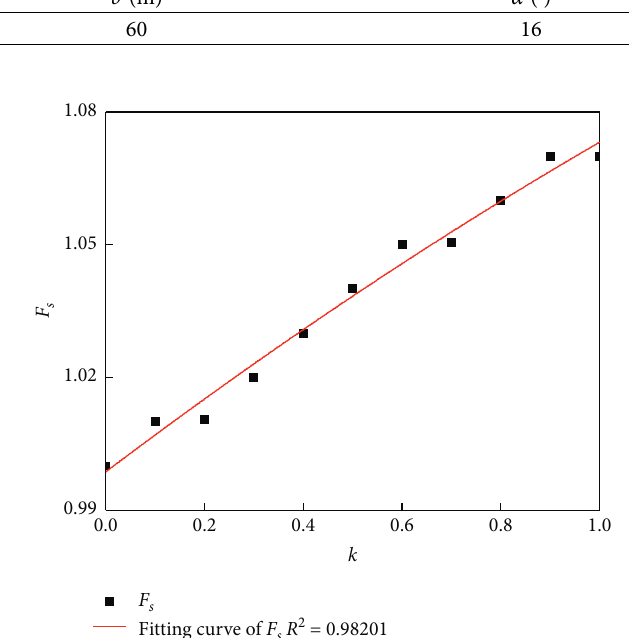
Figure 9: Variation of F